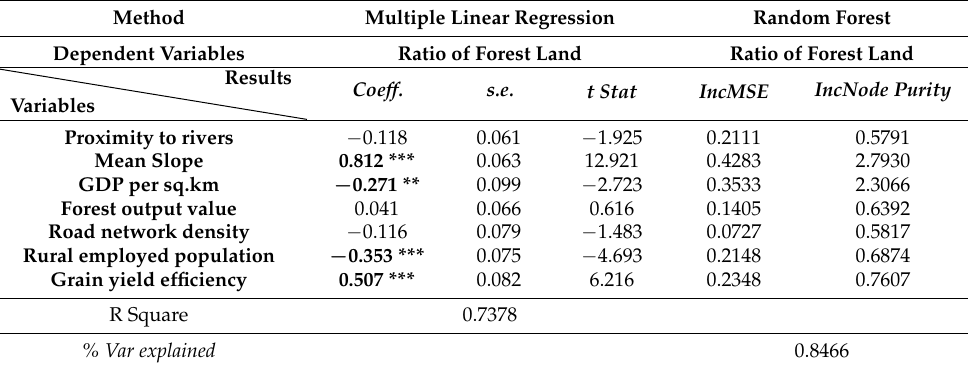
Table 3. Results by multiple linear regression and random forest.